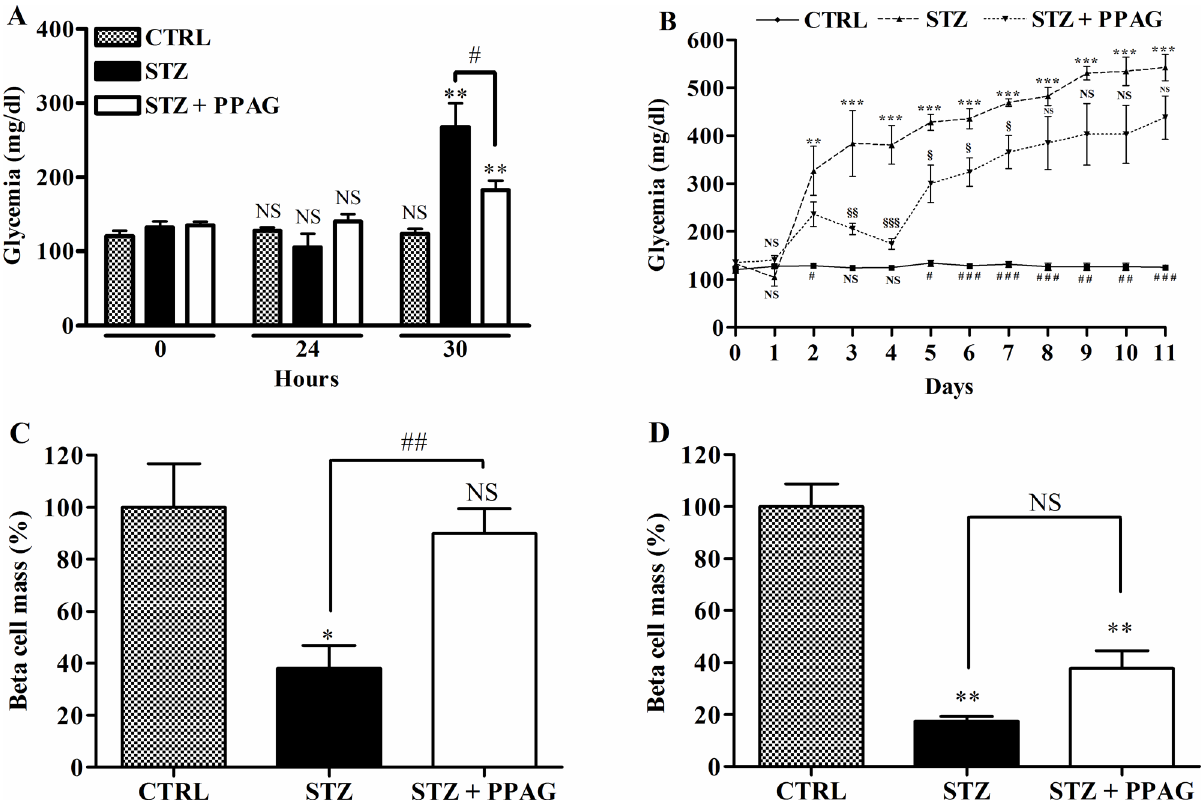
Fig 1. Effect of STZ and PPAG on blood glucose levels and beta cell mass in vivo. Shaded bars: untreated controls, CTRL (n = 10); filled bars: STZ-treated animals, STZ (n = 7); open bars: STZ-treated animals that were treated with PPAG, STZ+PPAG (n = 8). (A) Non- fasting blood glucose levels immediately before and 30 hours after a single injection of STZ. (B) Daily follow up of non-fasting blood glucose from immediately before a single injection of STZ until 11 days. Values are mean ± SEM. ANOVA with Bonferroni post test was used to determine the significance between groups on each day. ** p < 0.01; *** p < 0.001 between control and STZ group. #p < 0.05; ## p < 0.01; ###p < 0.001 between control and STZ + PPAG group. § p < 0.05; §§ p < 0.01; §§§ p < 0.001 between STZ and STZ + PPAG group. (C) Percentage of beta cell mass normalized to the control 30 hours (C) or 11 days (D) after STZ injection. Data shown are means ± SEM. ** p < 0.01; #p < 0.05; NS: not significant.